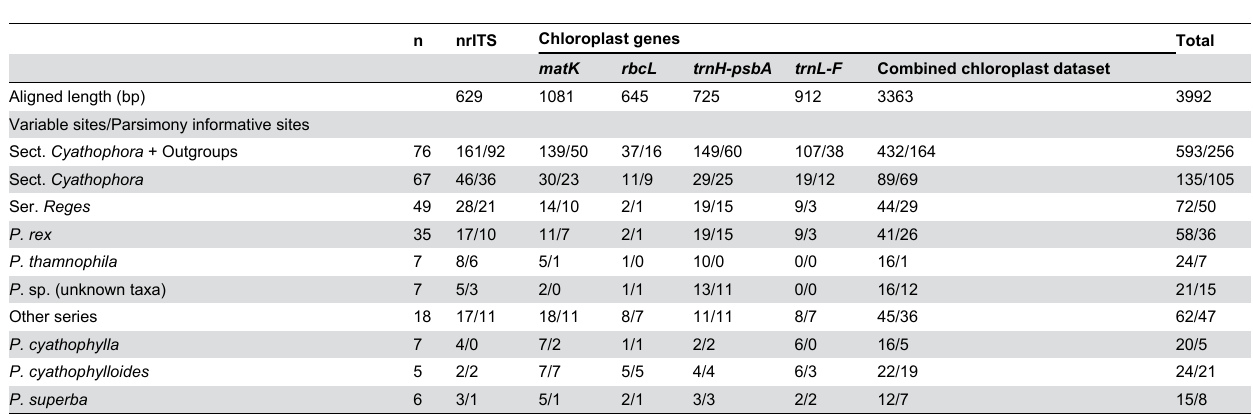
Table 2. Summary of nrITS and chloroplast